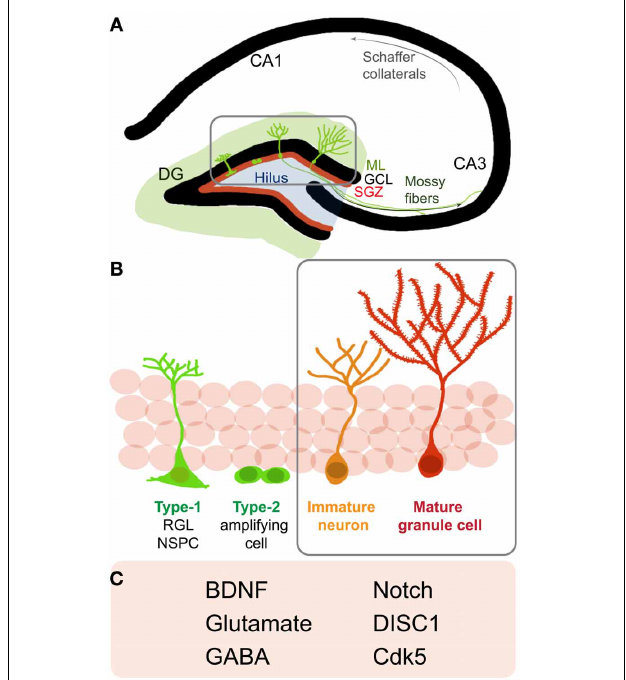
FIGURE 1 | Neurogenesis in the adult rodent hippocampus (A) Schematic of a coronal section of the hippocampus: cornu ammonis (CA) regions and the dentate gyrus (DG). Depicted are neural stem/progenitor cells (NSPCs) (green cells) residing in the subgranular zone (SGZ, red line) at the border of the granule cell layer (GCL) and molecular layer (ML). (Gray box) NSPCs divide, mature and go through the different stages of development and send out dendrites into the molecular layer and axons to the CA3 region via the mossy fiber pathway. (B) A closer look at neurogenesis reveals that adult NSPCs go through distinct stages of maturation where Type-1, radial glia-like stem cells give rise to Type2 transit amplifying cells, which divide to generate immature neurons that start developing characteristic DG granule cell morphologyand finally mature and integrate into the DG circuitry as mature granule cells. (C) Listed are some notable regulators of later stages (B , gray box ) of newborn neuron maturation and integration: brain derived neurotrophic factor (BDNF), gamma-Aminobutyric acid (GABA), Disrupted-in-Schizophrenia1 (DISC1), cyclin-dependent kinase 5